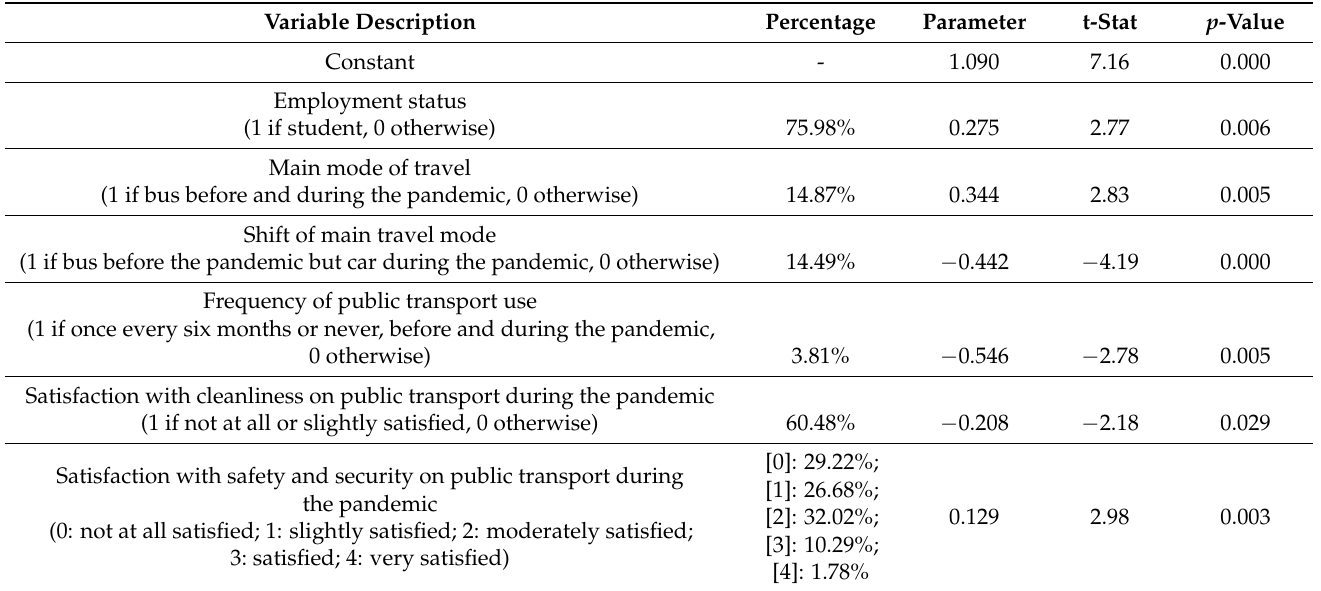
Table 2. Estimation results of the HOPIT model for expectations towards the public transport use